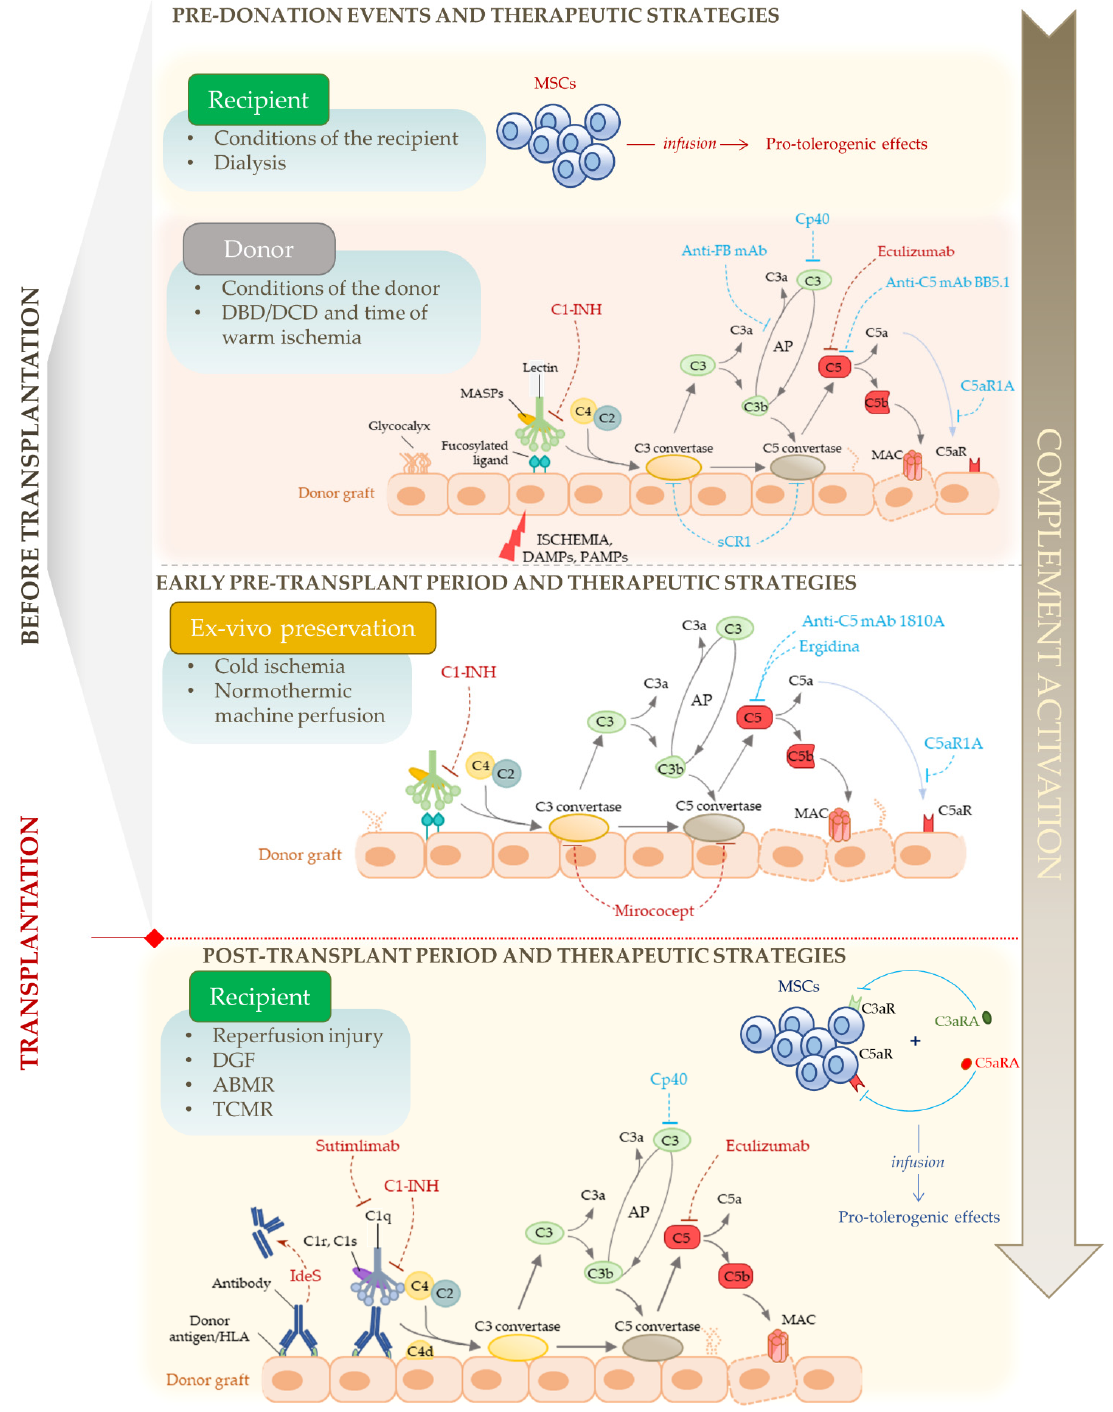
Figure 2. Schematic representation of the involvement of complement cascade activation in the sequential steps of kidney transplantation. Complement system might be activated before organ procurement, both in the recipient (e.g., for primary medical conditions and/or during dialysis sessions), and in the donor, whose pre-existing conditions significantly influence the graft quality and outcome. Moreover, the warm ischemia in the donor (during organ procurement and in DBD/DCD donation) and the cold ischemia during ex vivo preservation of the organ determine the release of DAMPs and increase the expression of fucosylated molecules by the ischemic injured tissue, triggering the activation of the lectin pathway, which is then amplified by the alternative